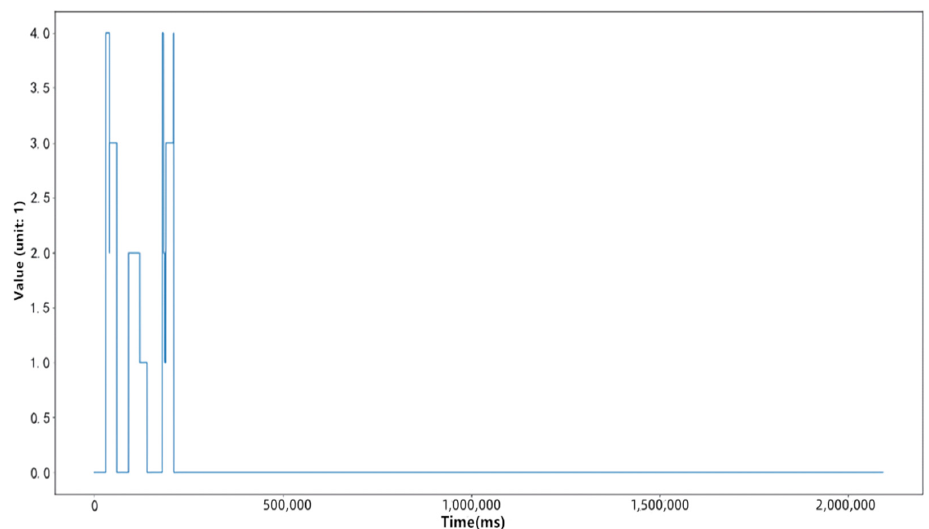
Figure 5. Time series of SAX dimensionality reduction compression based on gaussian mixture clustering.